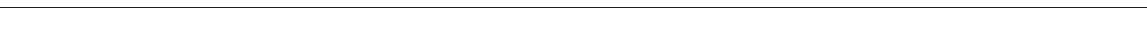
Fig. 5 Grail ubiquitinates the IL-21 receptor. a FACS-sorted naive WT and Grail − / − CD8 + T cells were treated with or without IL-21 for the indicated time points (0 – 60 min). The whole cell lysate was subjected to western blot assay to detect the levels of phosphorylated and total STAT1, STAT3 and STAT5. β - actin was used as a loading control. b Naive WT and Grail − / − CD8 + T cells were treated with or without IL-21 for 7 min, followed by western blot to detect the phosphorylated and total JAK1 levels. β -actin was used as a loading control. c γ C (CD132) and IL-21R α protein levels on the surface of naive untreated WT and Grail − / − CD8 + T cells. Numbers in dot plot quadrants represent the percentages of each subset. d About 293T cells were transfected with vectors encoding CD132 or IL-21R α , HA-Ub, and either Grail or a Grail mutant (Grail-m). The lysates were subjected to immunoprecipitation (i.p.) using an anti- FLAG or anti-CD132 antibodies. The blots were probed with anti-HA-HRP and re-probed with anti-FLAG or anti-CD132. e Naive WT and Grail − / − CD8 + T cells were activated with OVA peptide and irradiated WT APCs alone or with Latrunculin B. γ C (CD132), IL-21R α , CD25, CD122 and IL-7R expression on CD8 + T cells were assessed 48 h after activation. Numbers in dot plot quadrants represent the percentages of each subset. All experiments were independently performed three